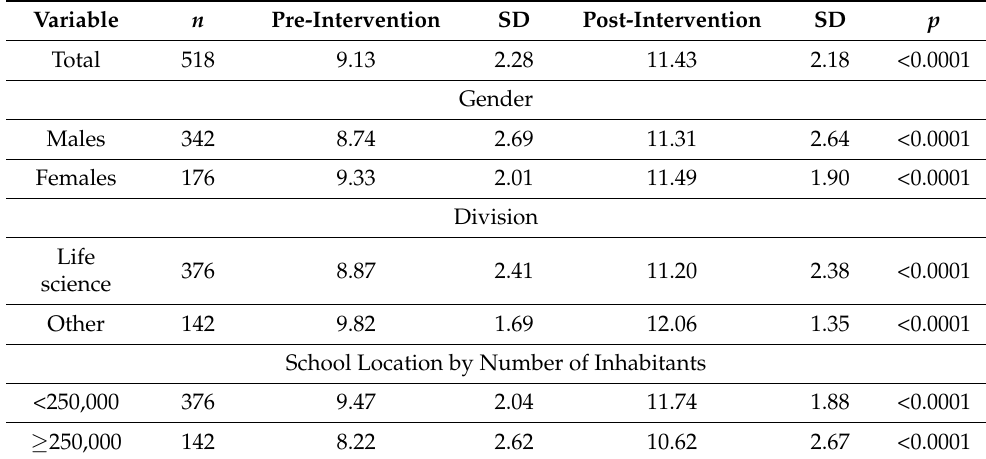
Table 1. Overall knowledge scores pre- and post-COVID-19 intervention by selected variables; final year high school students, Poland, 2020 ( n =